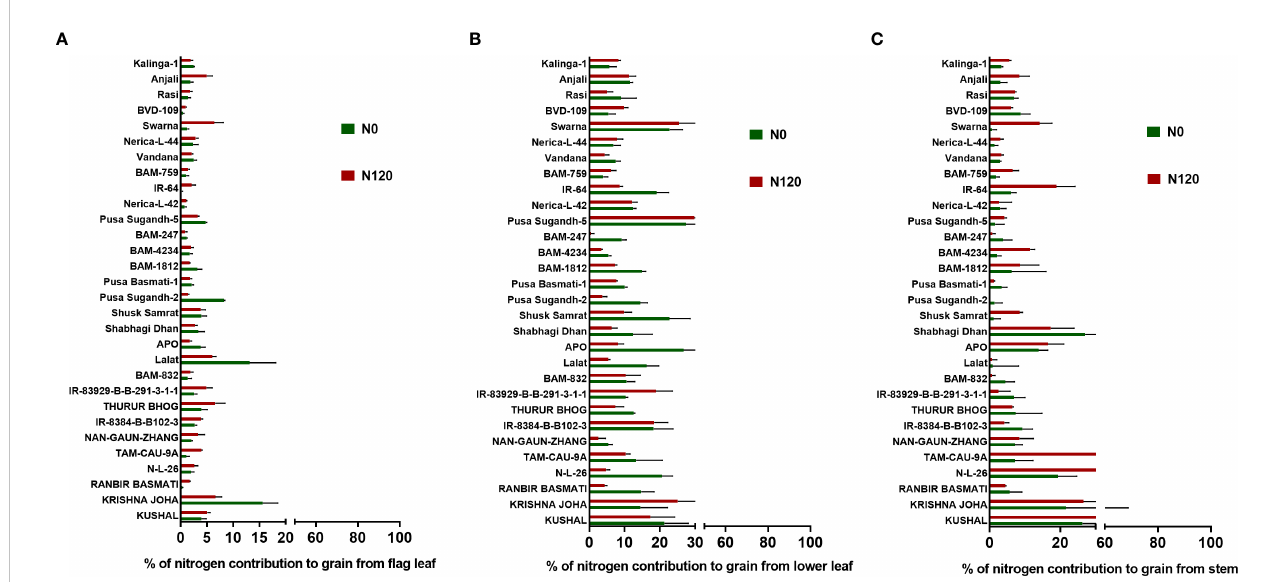
FIGURE 9 Effect of nitrogen de fi cient (0 kg ha-1 fertilizer N: N0) and nitrogen suf fi cient (120 kg ha-1 fertilizer N: N120) fi eld conditions on (A) (%) percentage of nitrogen contribution to grain from fl ag leaf, (B) , (%) percentage of nitrogen contribution to grain from lower leaf, and (C) (%) percentage of nitrogen contribution to grain from the stem in fi eld- grown diverse rice genotypes during the 2019-kharif season. Values presented are Mean±SE with three